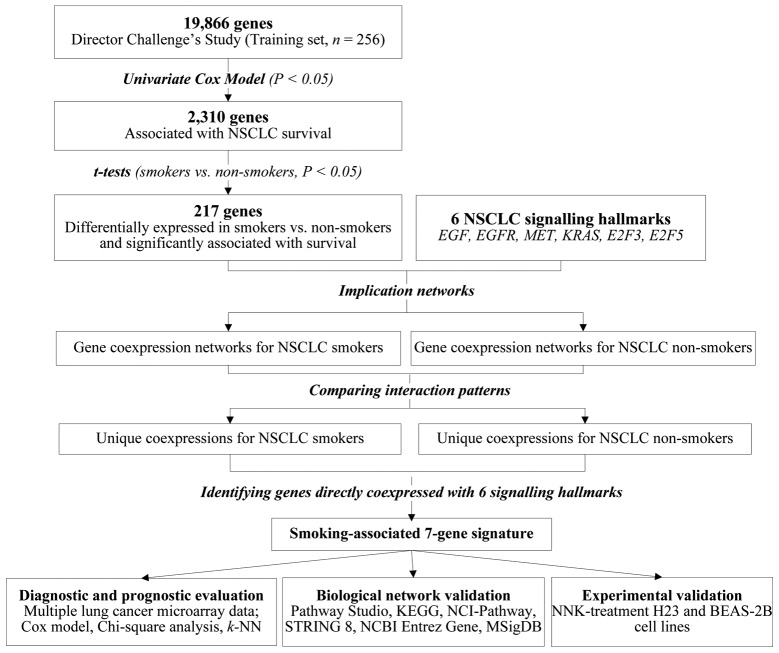
Methodology for network-based identification of smoking-associated 7-gene signature.